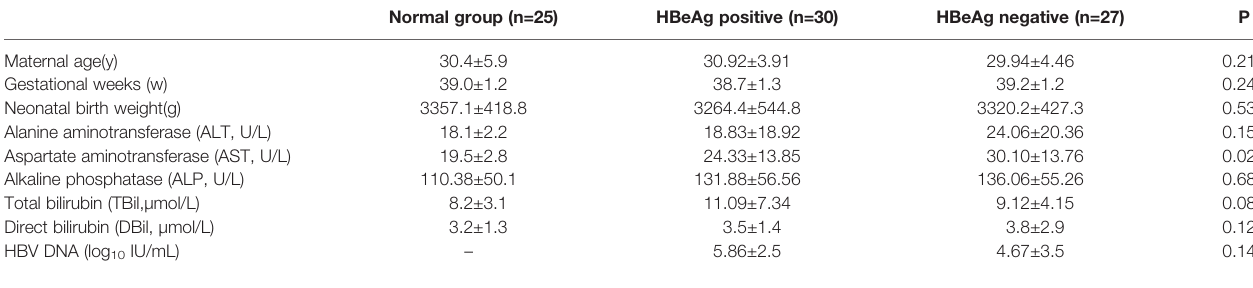
TABLE 2 | Clinical data of different HBeAg expression groups.